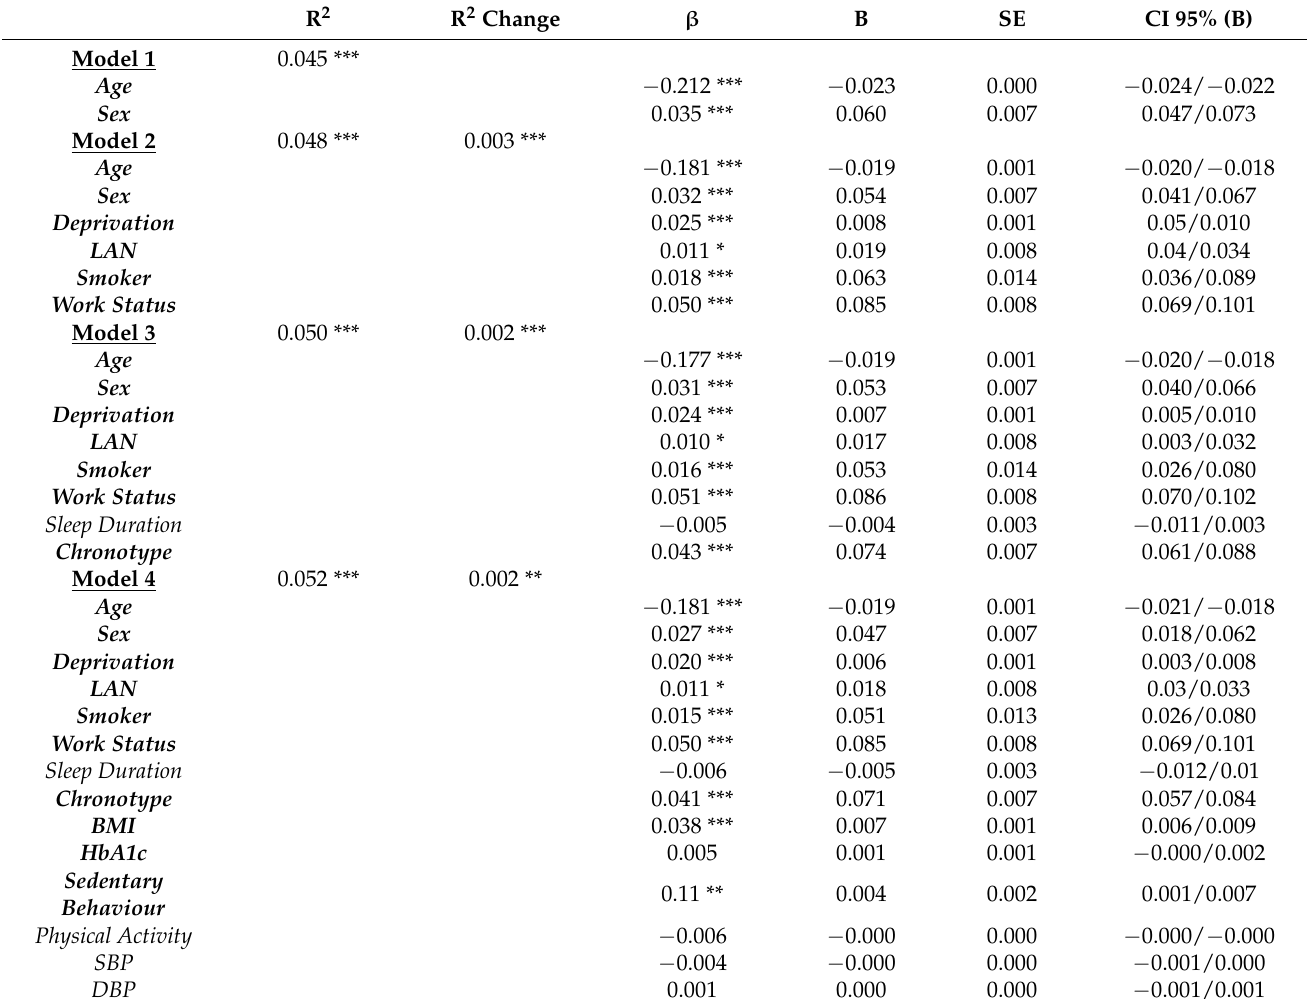
Table 2. Hierarchical MultipleLlinear Regression Models with Absolute WD/WE Sleep Offset Difference as the Dependent Variable for the Full Sample.